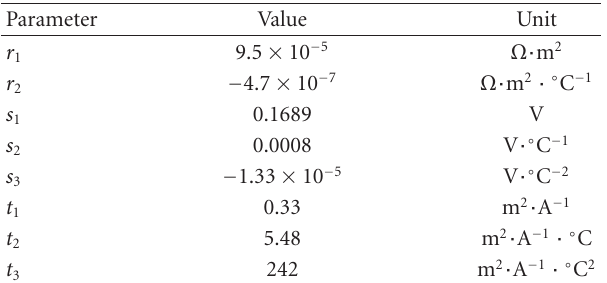
Table 1: Electrolyzer mode parameters.